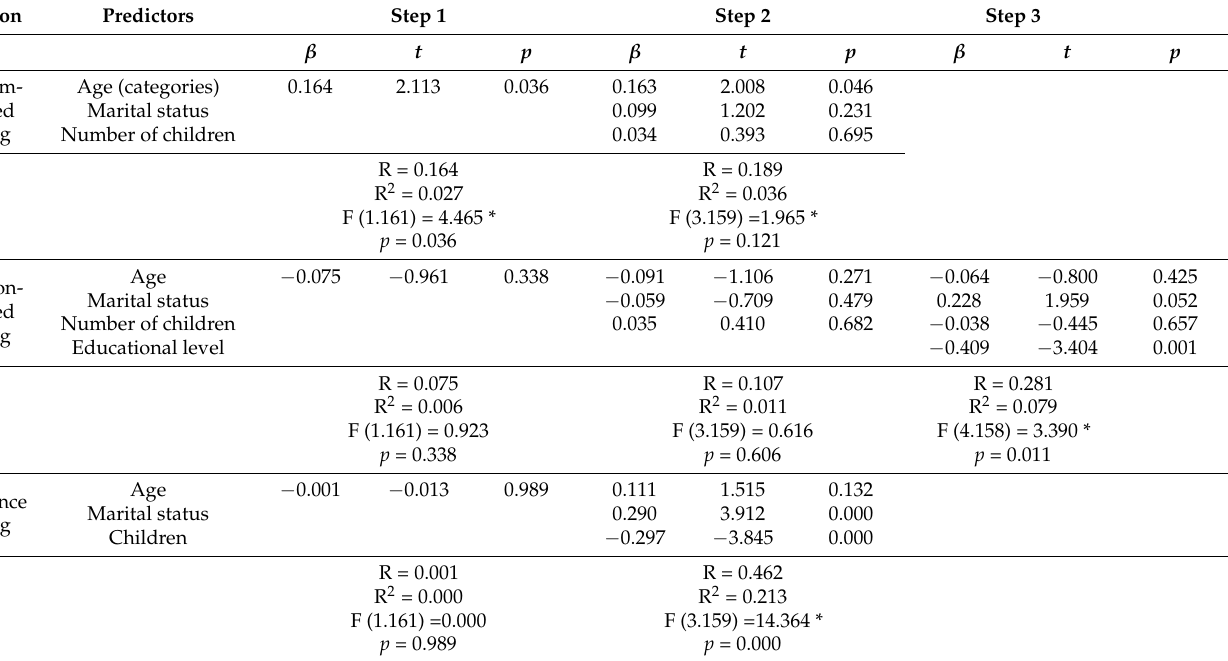
Table 5. Results of the stepwise regression analysis using coping strategies as a criterion in non- CoV